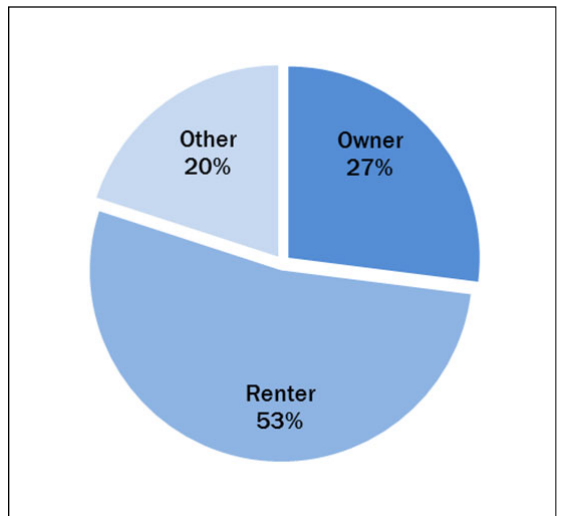
Figure 4. Tenure Status of Urban Farmers